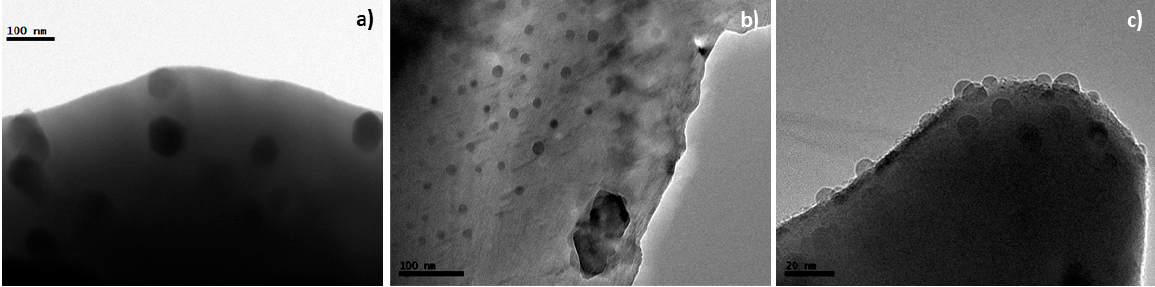
Figure 10. TEM images obtained after annealing at 1173 K for 250 h for ( a ) La 2 NiTiO 6 and ( b , c ) La 1.8 NiTiO 6 −δ .